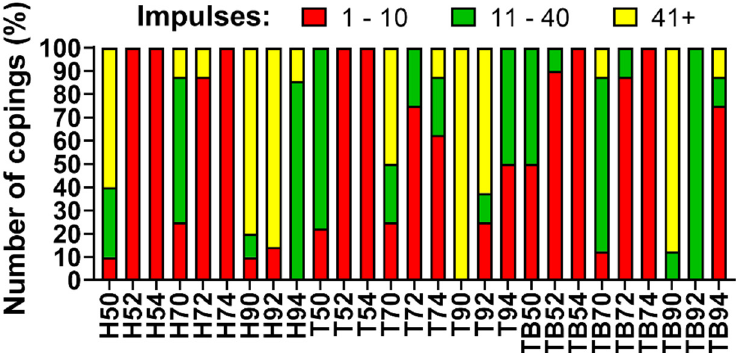
Figure 7. Copings retrievability index: observed percentage of instability (red), good retrievability (green) and no retrievability (yellow).